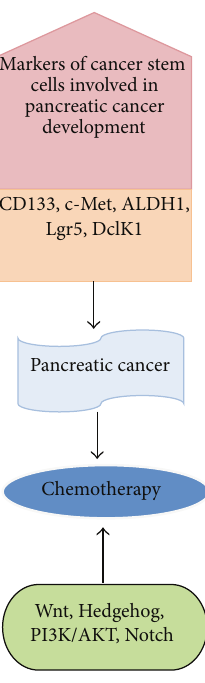
Figure 1: The role of cancer stem cells markers during pancreatic cancer development. The cartoon recapitulates the role of cancer stem cells markers during pancreatic cancer development and the signaling pathways